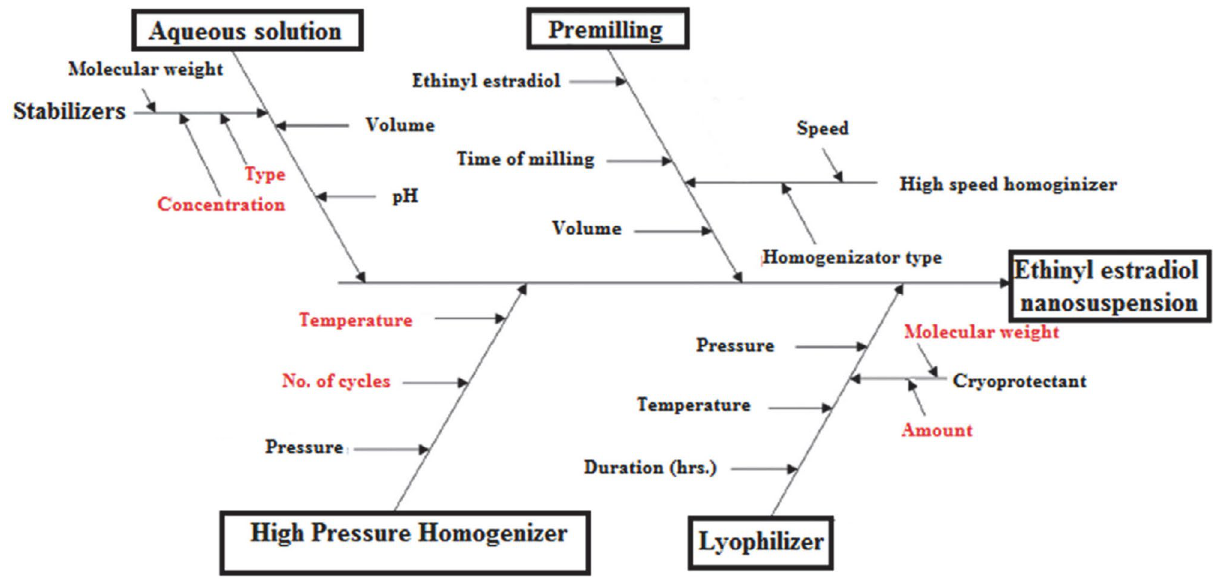
Figure 2. An Ishikawa diagram illustrating process and formulation variables that may influence the properties of NS.